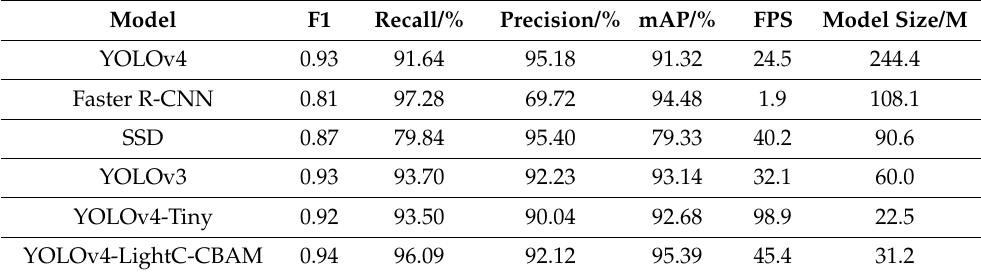
Table 5. Comparison test table with other algorithms.